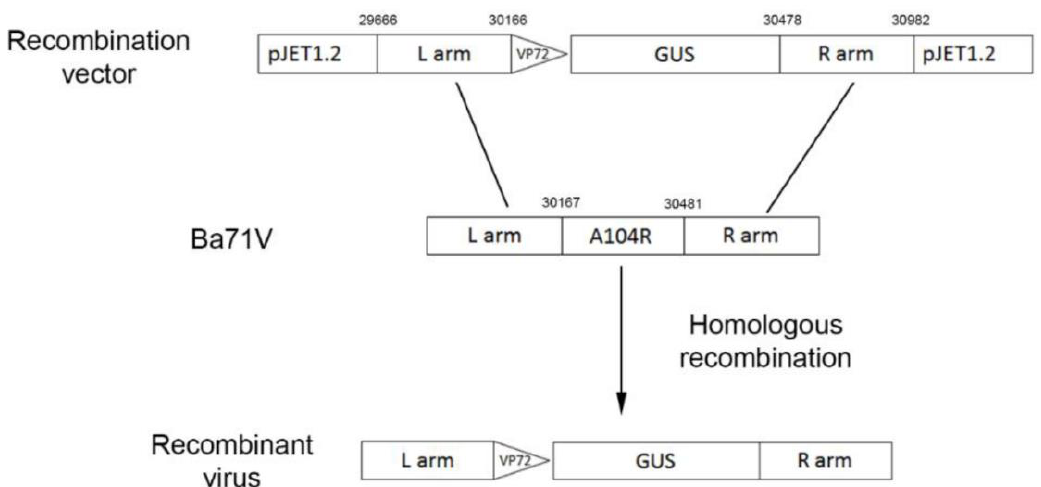
Figure 3. Schematic representation of the adopted strategy to generate the recombinant African swine fever (ASF) viruses. The target A104R gene was replaced by the reporter gene ( GUS ). The recombinant virus was obtained by homologous recombination between the left and right sequence regions (L arm and R arm) of the A104R gene on wild-type ASFV-Ba71V genome and recombination vector, resulting in the deletion of A104R gene and insertion of GUS gene under control of the strong viral promoter of the ASFV-VP72 gene.